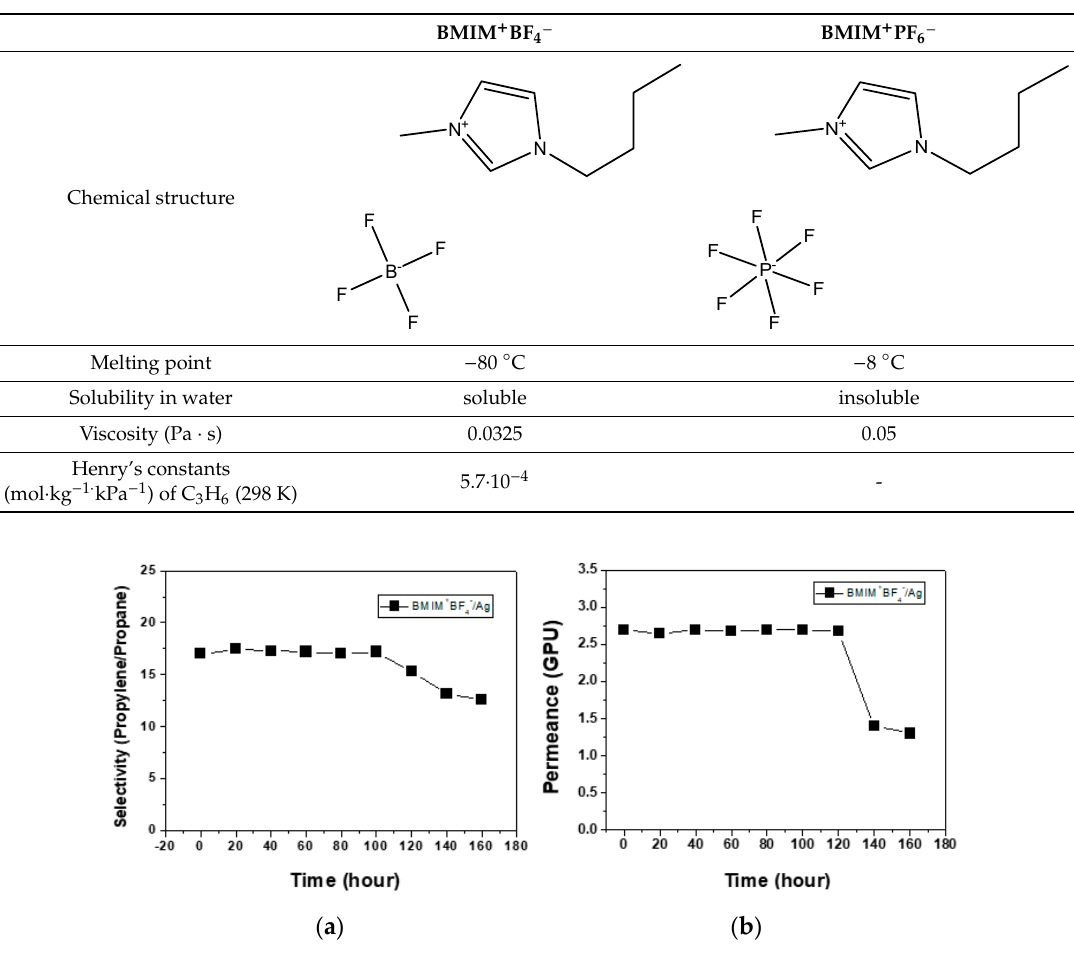
Figure 2. Separation performance: ( a ) mixed gas selectivity and ( b ) total permeance of 1/0.7 BMIM + BF 4 − /Ag membranes as a function of time (40 psig and 20 °C).